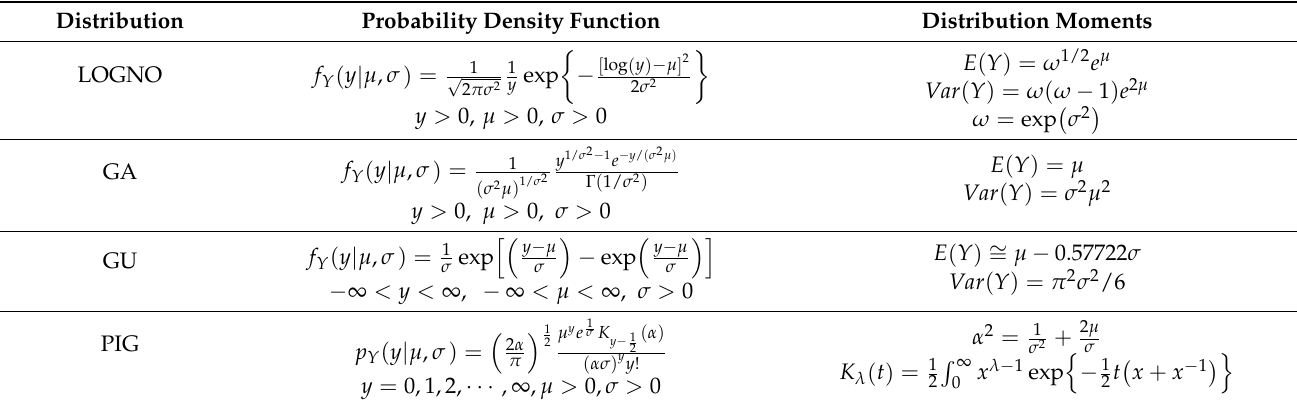
Table 1. Summary of the four two-parameter distributions considered in this study to model the streamflow data. LOGNO means Log normal distribution; GA means Gamma distribution; GU means Gumbel distribution; PIG means Poisson inverse Gaussian